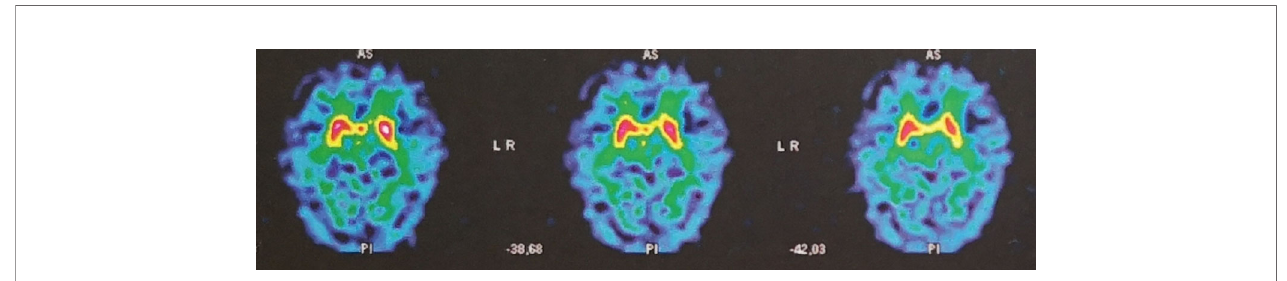
FIGURE 2 | DaT-SCAN SPECT from patient #2, showing bilateral reduced striatal uptake, predominant in putamen, in favor of presynaptic dopaminergic